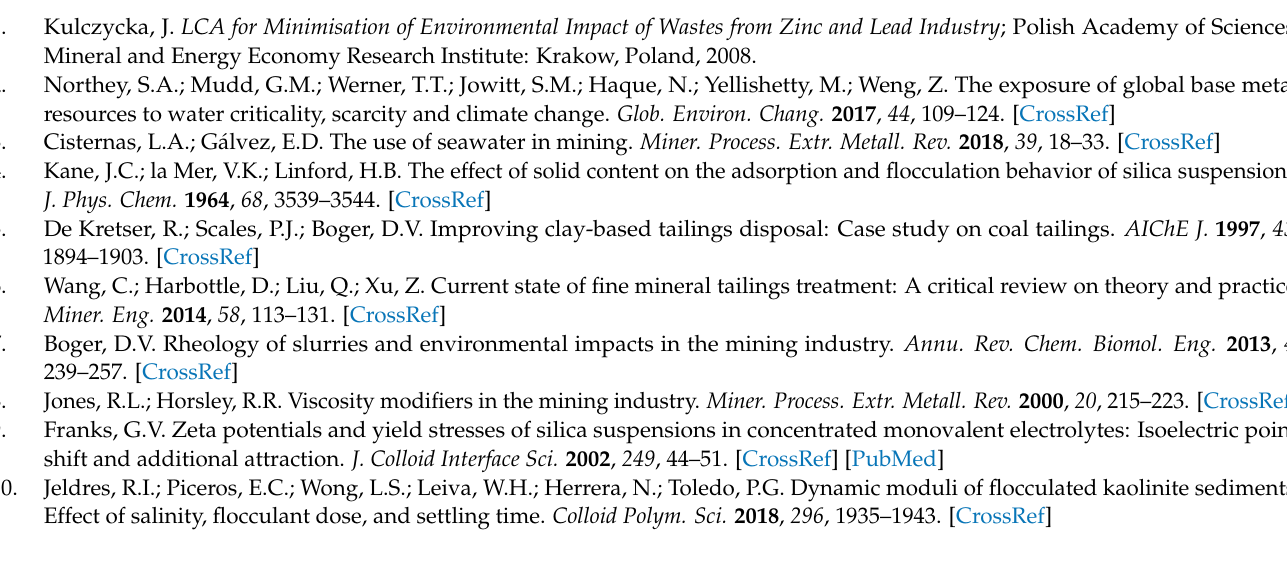
Table S3: Angle parameters, harmonic function, Table S4: Torsion parameters, RB function, Table S5: Planar torsion parameters, cosine function, Table S6: PAA partial charges, Table S7: Kaolinite partial charges for individual cells (supercell 16x12x2 (384)), Table S8: Montmorillonite partial charges for individual cells (supercell 16x6x2 (192)), Table S9: Quartz partial charges for individual